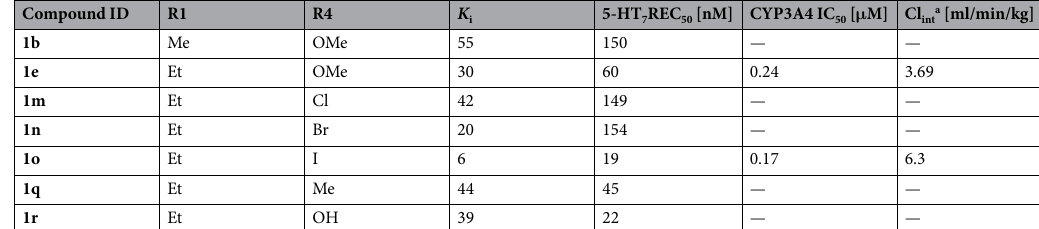
Table 1. Results of functional activity for 5-HT 7 R, CYP3A4 inhibition assay and metabolic stability for the selected compounds. a Metabolic clearance (human liver